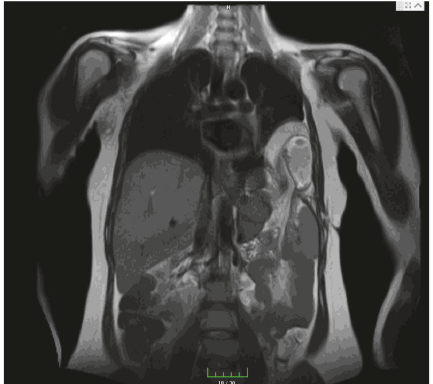
Figure 2: Thoracoabdominal magnetic resonance imaging showing irreducible Bochdalek hernia.